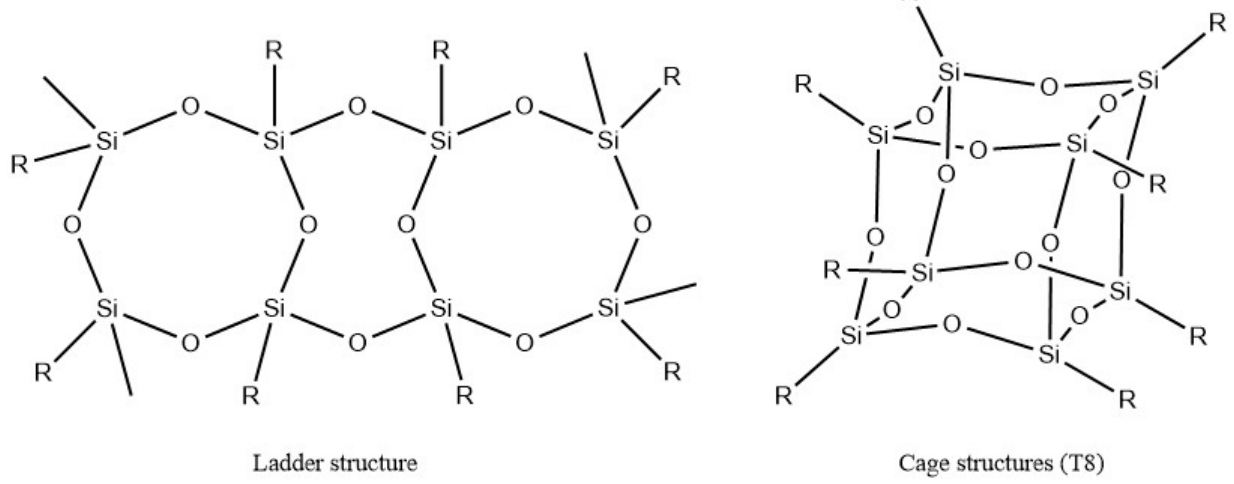
Figure 13. Schematic representation of Silsesquioxanes [165]. Fan et al. has reported a crosslinked polyimide with functionalized cage POSS as crosslinker [175,176]. The improvement of thermal properties of PI was confirmed by DSC and TGA tests, including increase in the T g and thermal stability. The most significant outcome is the LOI increase from 46.5% for neat PI to 57% with 5.43 wt.% of